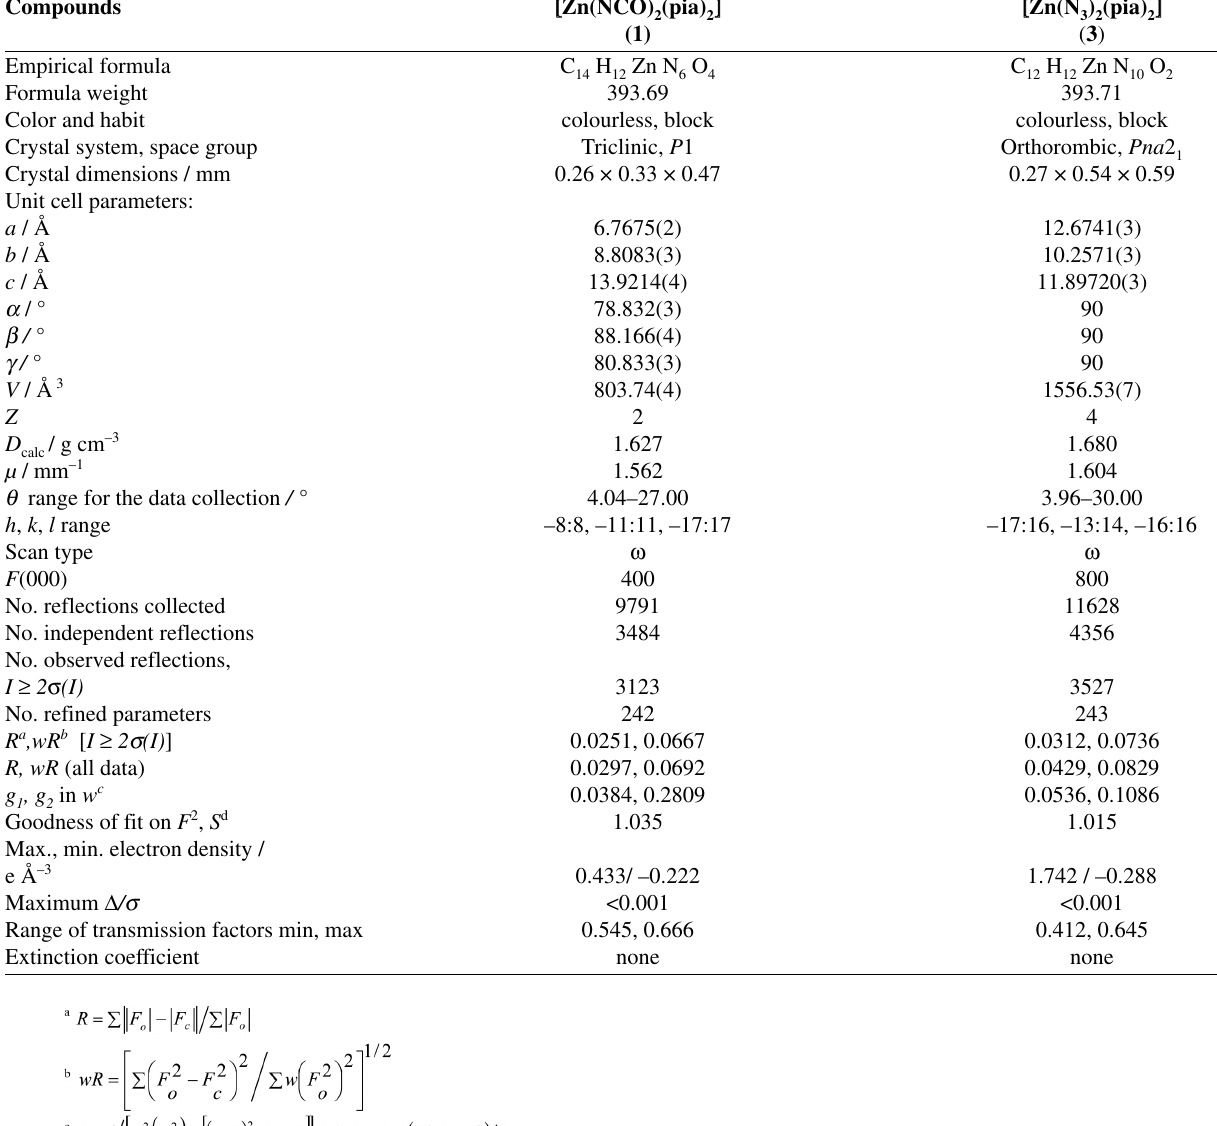
Table 1. Crystal data and structure refinement for complexes 1 and 3 .